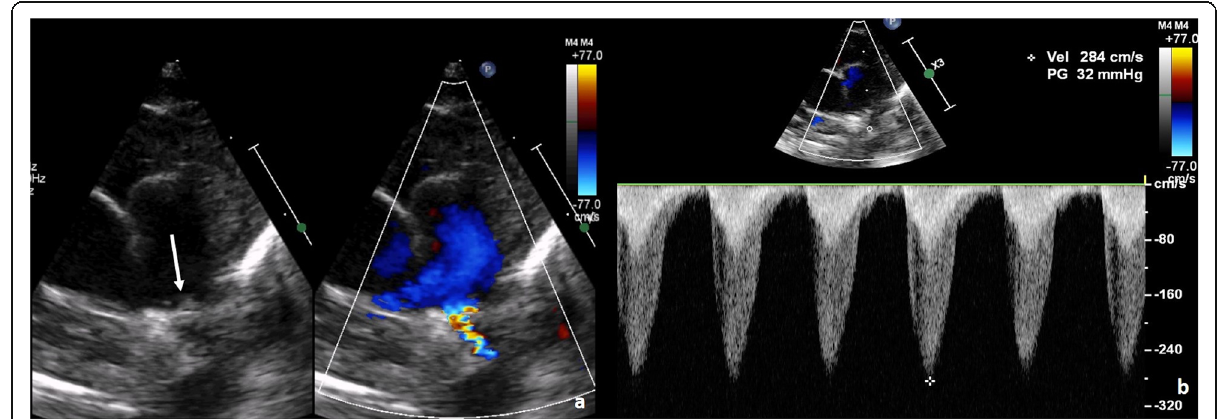
Fig. 1 a Echocardiogram with colour Doppler in parasternal short axis view showing turbulent flow across LPA along with luminal narrowing (arrow). b Echocardiogram with continuous wave Doppler showing gradient across LPA